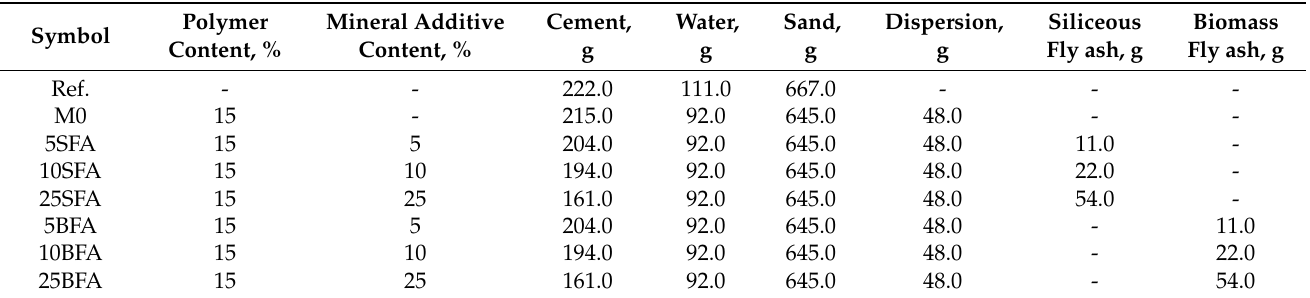
Table 2. Material composition of designed mortars per 1 kg of